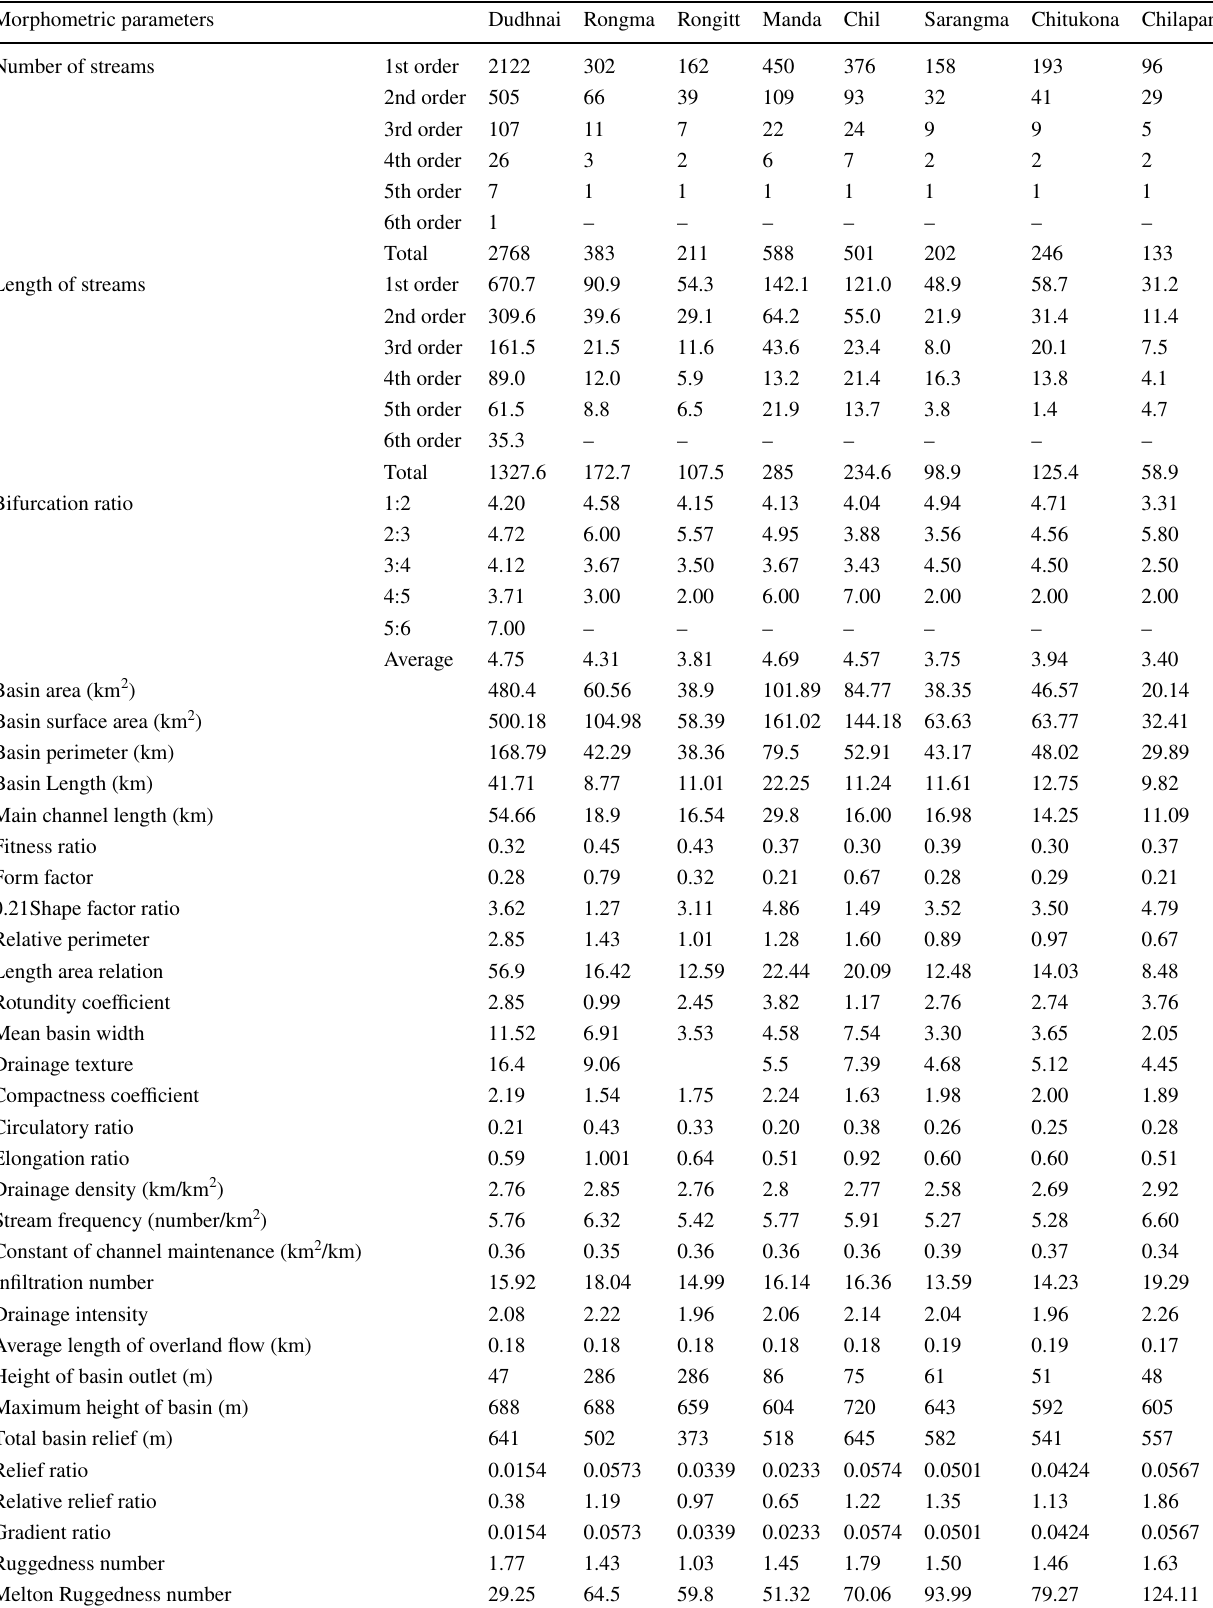
Table 2 Analysis results of the morphometric parameters of Dudhnai watershed and its seven sub-watersheds Morphometric parameters Number of